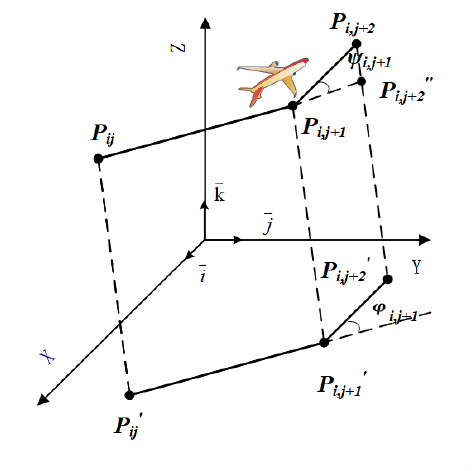
Figure 2. Turning and climbing angle